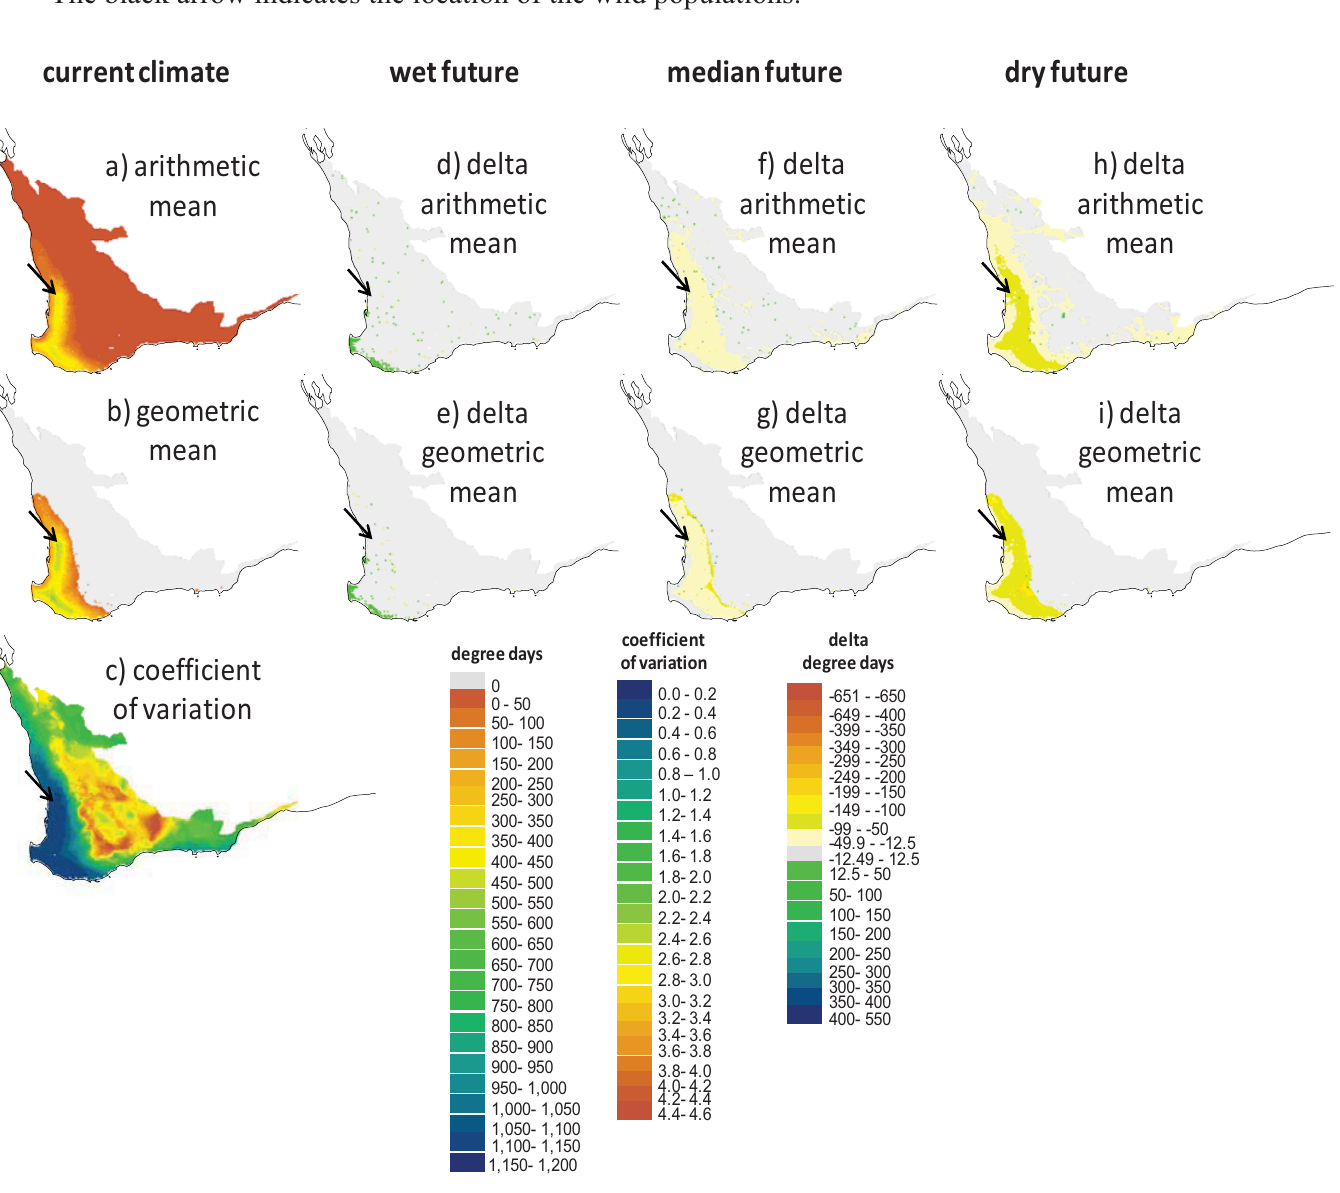
Figure 7. Screening maps of the output of NicheMapR coupled with WET-R showing ( a ), the arithmetic mean, ( b ) the geometric mean and ( c ) the coefficient of variation of the degree days above 14 °C, assuming the tortoises will remain in the water during the hydroperiod unless it exceeds the voluntary thermal maximum temperature. The degree day metric is proportional to the potential for feeding and assimilation . Models are driven by current climate (1990–2009: AWAP data, a – c ) and also indicated are the impacts of the three future climates for 2030 outlined in Figure 4 (future scenario—current scenario; d – i ). The black arrow indicates the location of the wild